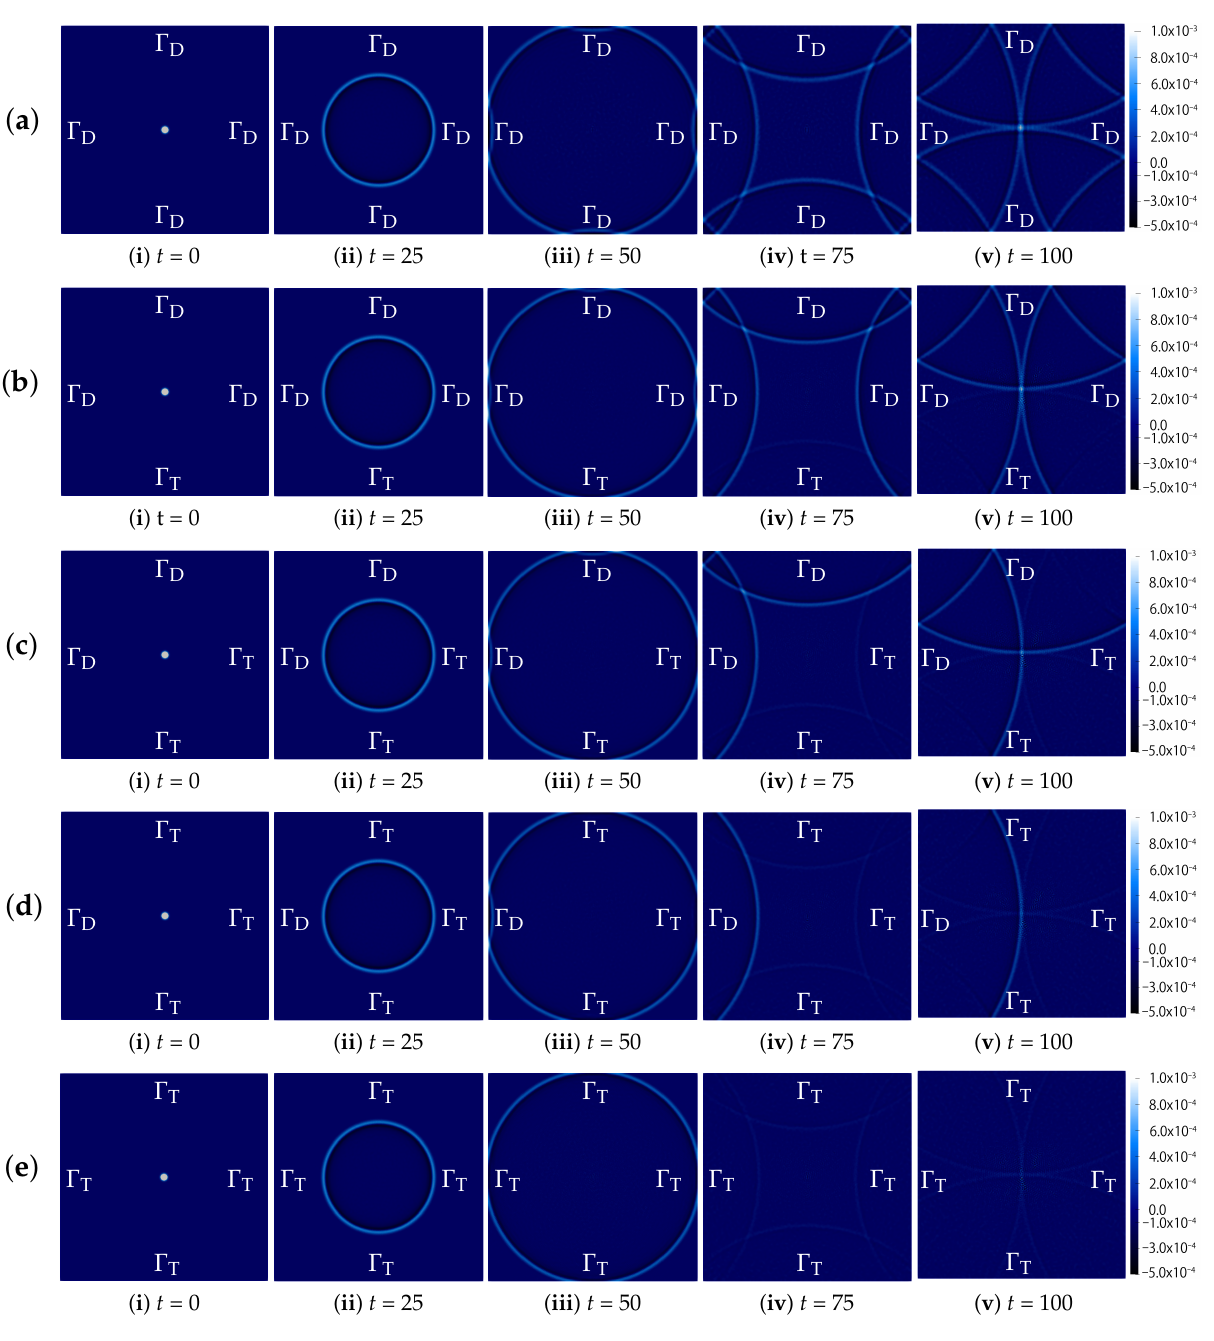
Figure 6. Color contours of η n by LG2 with and without the TBC for the five cases, ( a – e ), in Example h